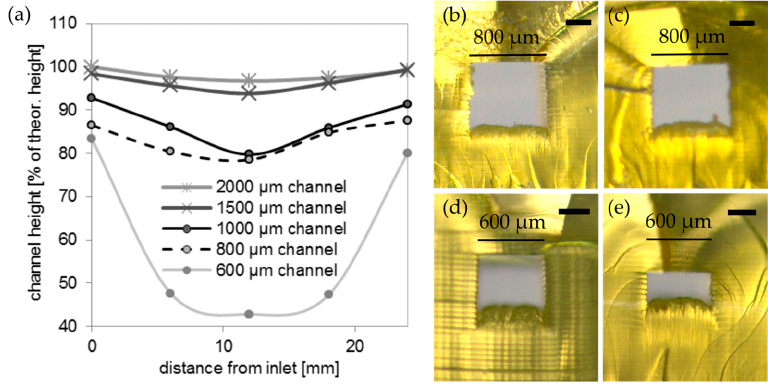
Figure 5. Characterization of the channel height of the printed PFPE methacrylates: ( a ) Height of a printed rectangular PFPE methacrylate channel for different spots from the inlet to the outlet. Channel heights decrease with distance from the inlet/outlet; ( b ) Lateral view of the 800 µm channel at the inlet, channel width of 800 µm, height of 692 µm (scale bar: 250 µm); ( c ) Cross section of the 800 µm channel in the middle, channel width of 800 µm, height of 628 µm (scale bar: 250 µm); ( d ) Lateral view of the 600 µm channel at the inlet, channel width of 600 µm, height of 500 µm (scale bar: 250 µm); and, ( e ) Cross section of the 600 µm channel in the middle, channel width of 600 µm, height of 257 µm (scale bar: 250 µm).